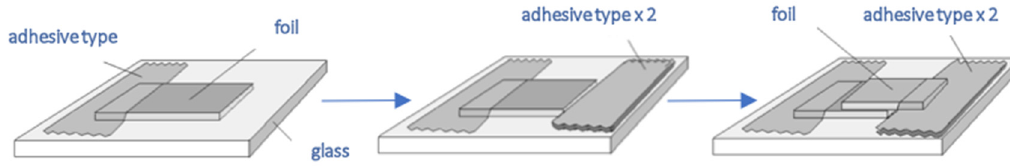
Figure 2. Configuration of the photodyne structures.